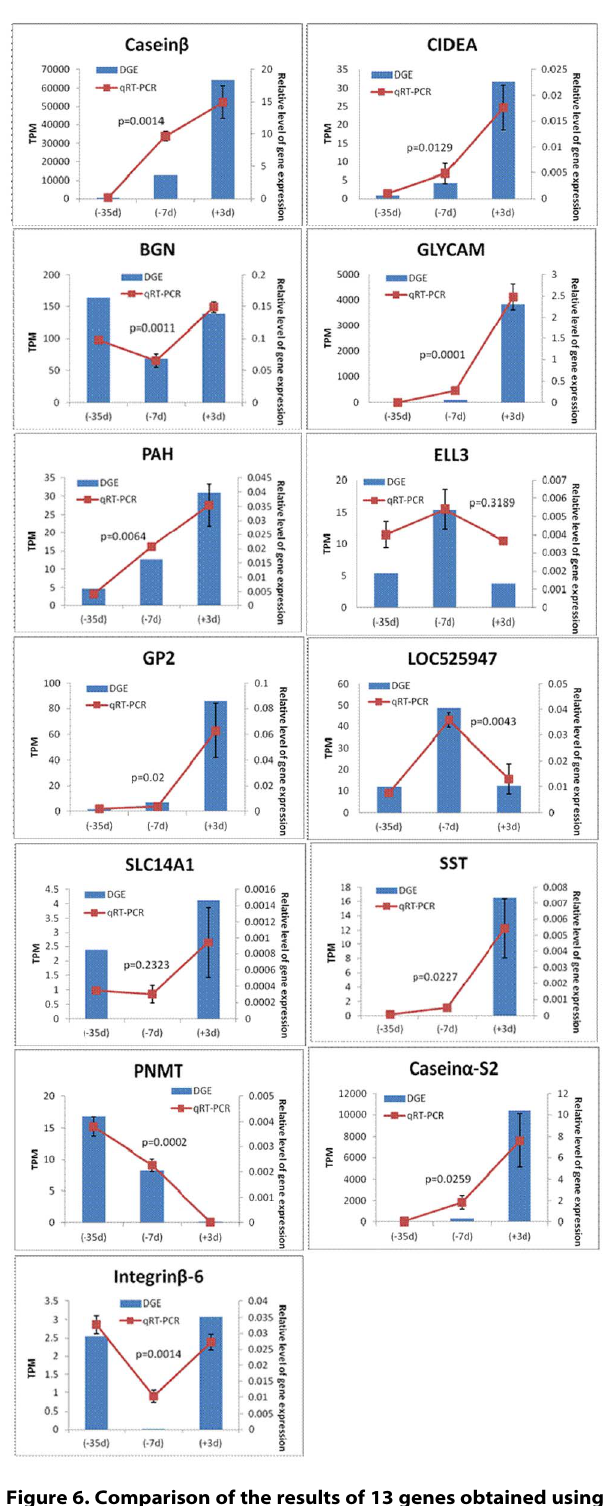
Figure 6. Comparison of the results of 13 genes obtained using DGE and qRT-PCR methodology. doi:10.1371/journal.pone.0070393.g006 a cDNA, these extra NlaIII tags represent genes redundantly present in the expression profile. Thus, the number of unique tags generated was greater than that of the annotated bovine genome.